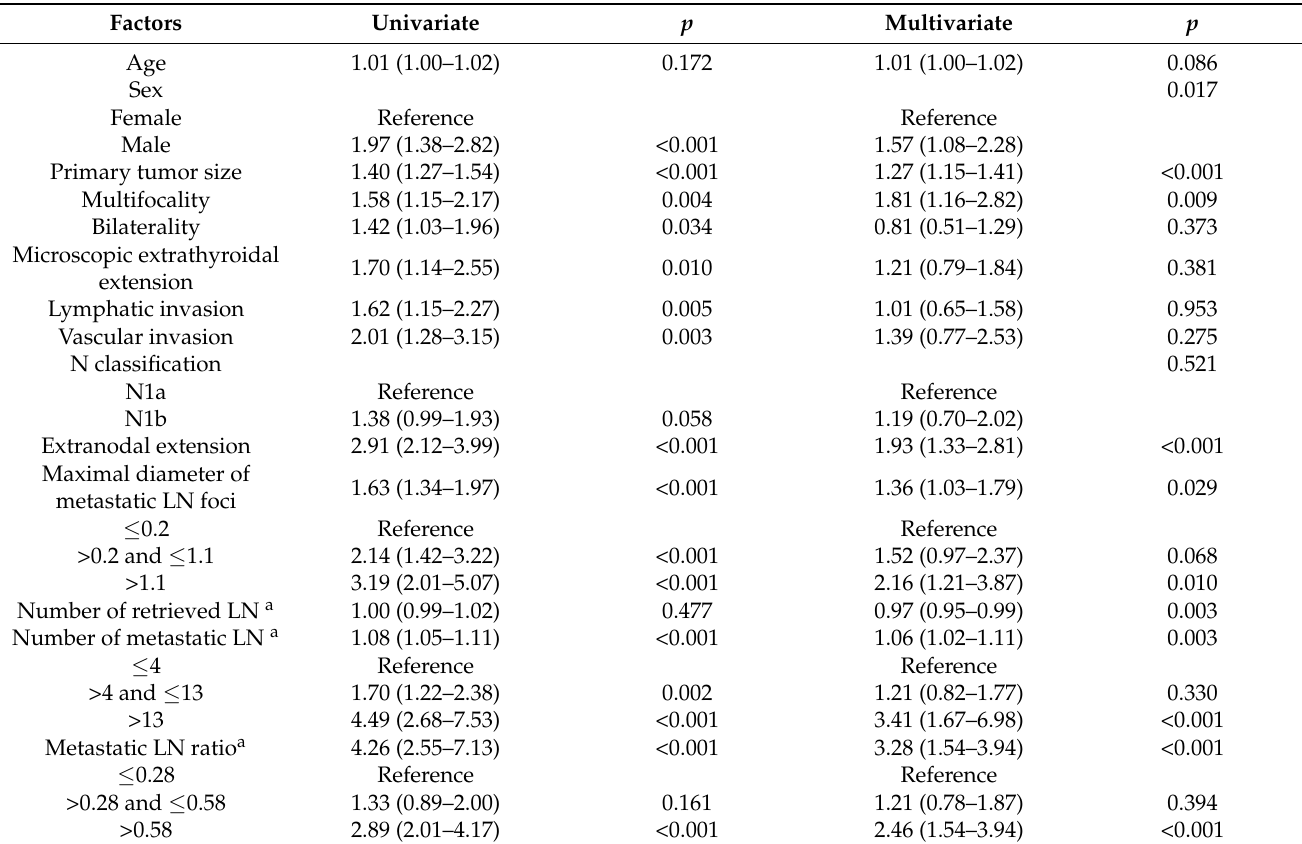
Table 2. Risk factor analyses for structural